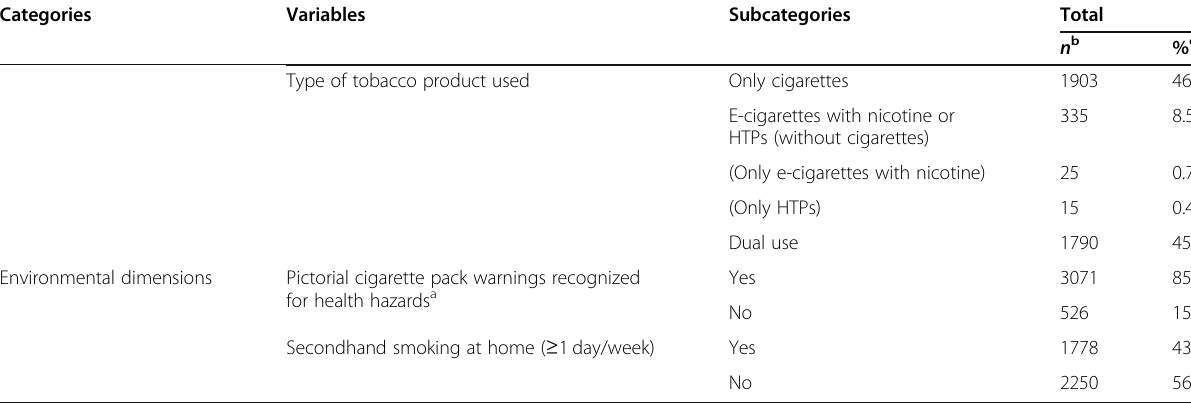
Table 1 Sample characteristics ( N = 4028)